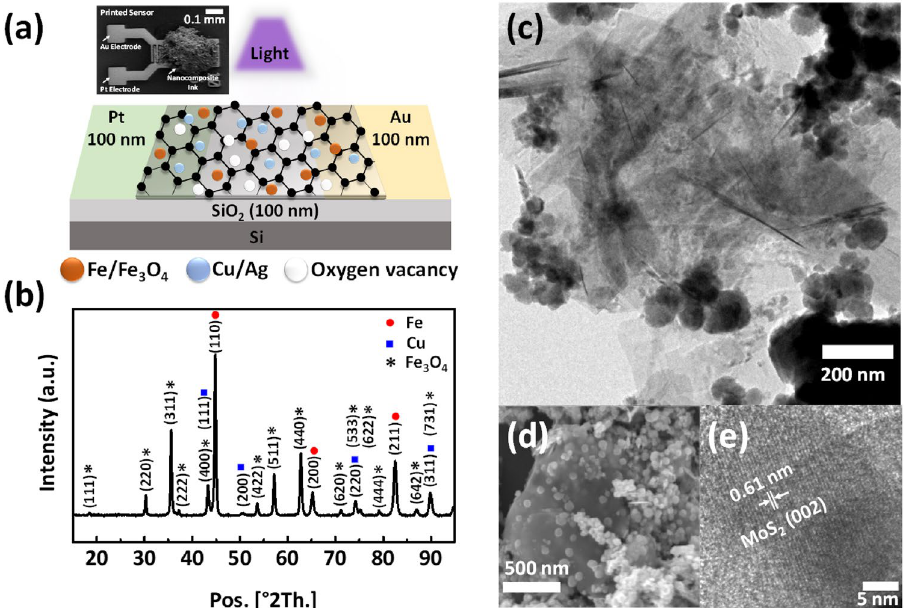
Figure 1. ( a ) Schematic IDE illustrating a two-terminal memristor structure with Au and Pt electrodes. Inset: Top view SEM image of the fabricated device including 2D-material as the light sensitive centers hosting fine degree of NPs. ( b ) XRD patterns of MFC composites. ( c ) and ( d ) TEM and SEM images of MFC composite, respectively. Both TEM and SEM images show that the 2D flakes have been decorated with metallic NPs. ( e ) HRTEM image of the MFC composite. The MoS 2 crystal could be clearly